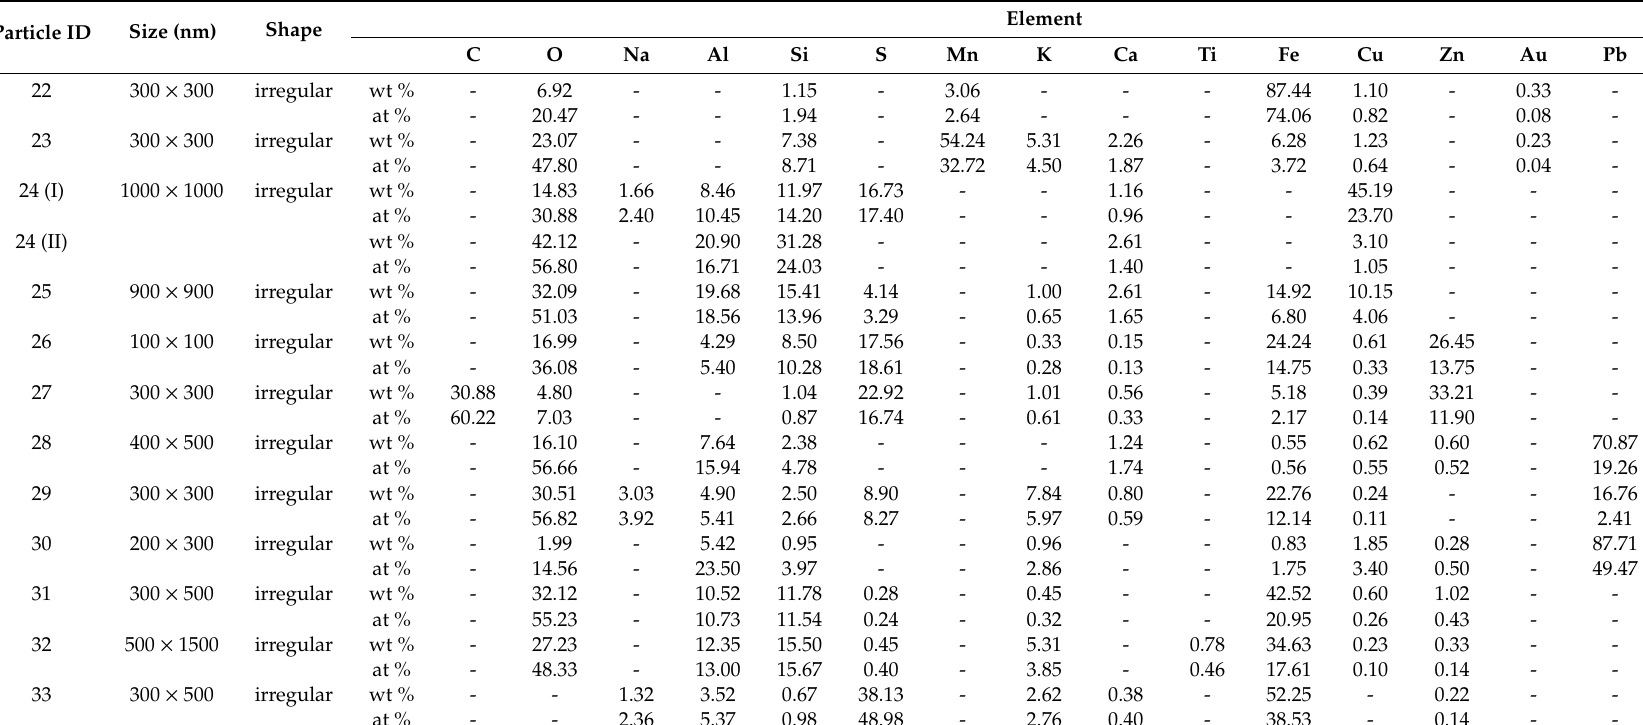
Table 3. Information about Au-, Pb-, Zn-, Cu-, and Fe-bearing nanoparticles in fault gouge over gold